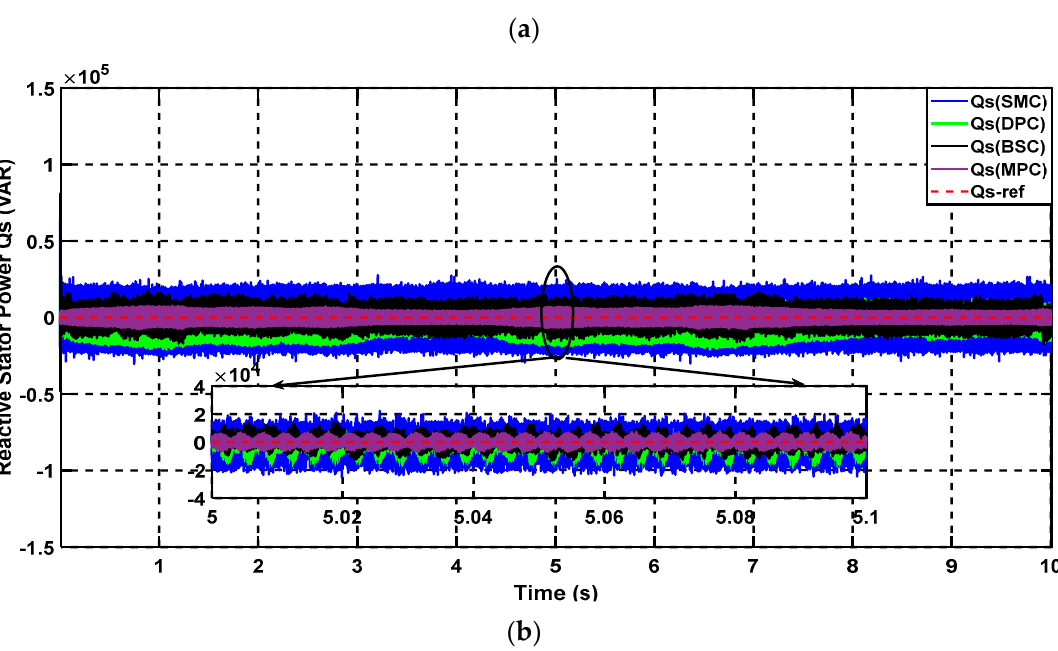
Figure 18. Active Stator power Ps ( a ), Reactive Stator Power Qs ( b ).